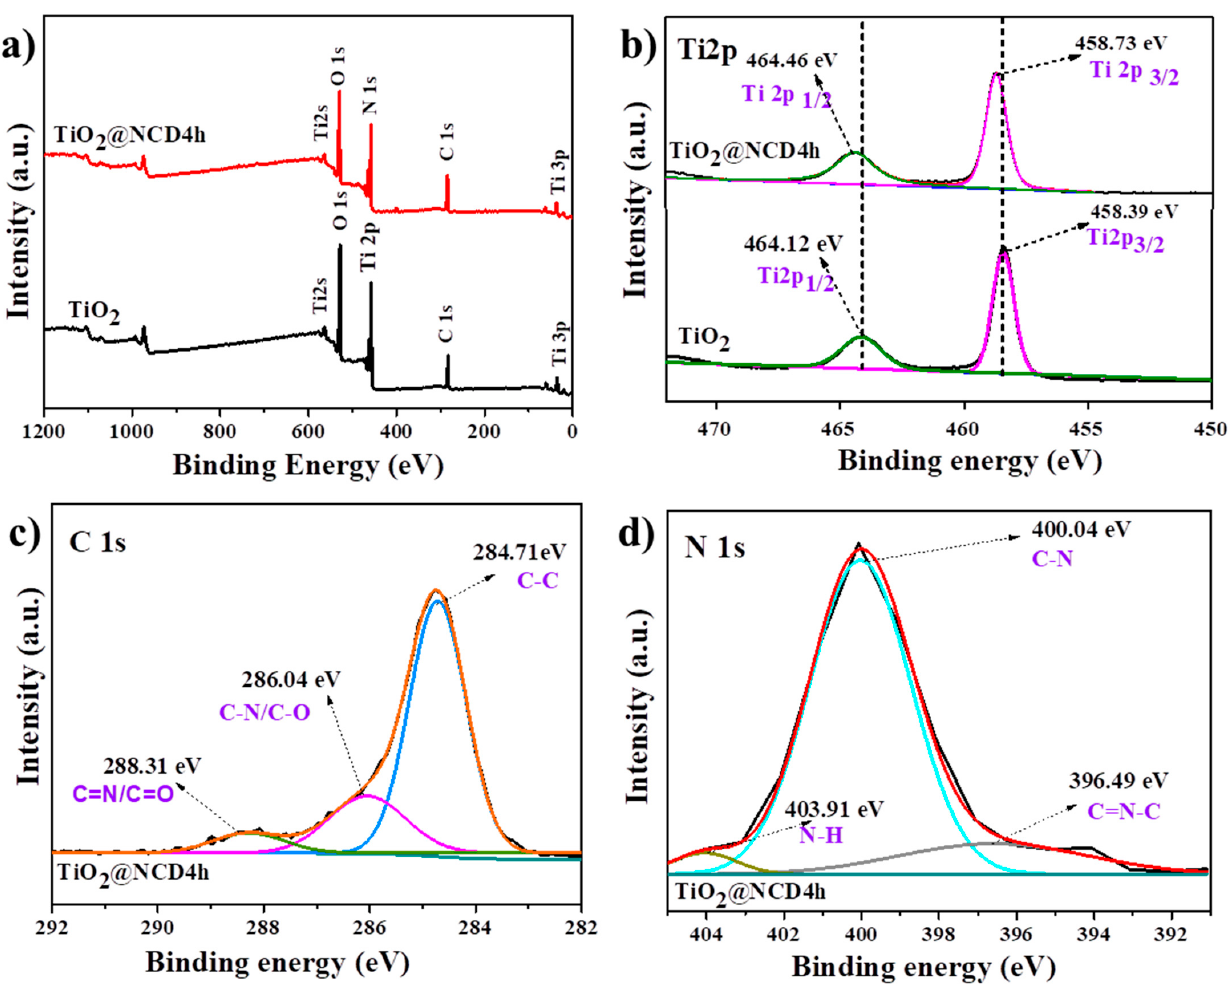
Figure 5. XPS spectra of pristine TiO 2 and TiO 2 @NCD4h ( a ) survey scan ( b )Ti 2p ( c ) C 1s ( d )N